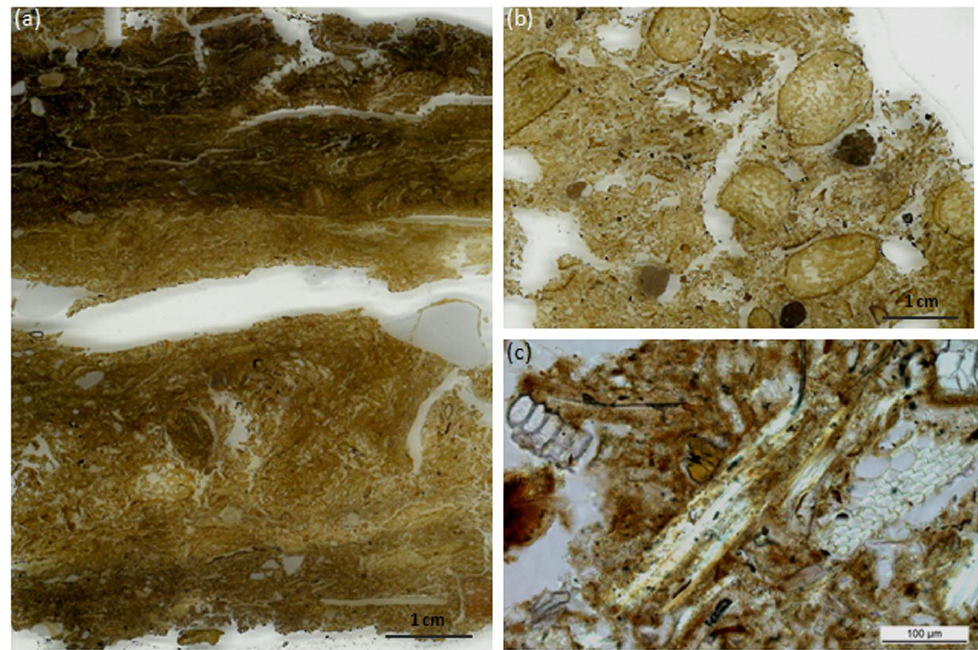
Figure 2. Modern dung cakes from Central Anatolia in Turkey (ethnographic and sample descriptions can be found in [6,29]). ( a ) Scan of a resin-impregnated thin-section illustrating the trampled structure of compacted cattle faeces from an enclosure containing organic material and other mineral inclusions; ( b ) scan of a thin-section from a dung cake manufactured in winter composed of sheep dung pellets, organic matter, and mineral inclusions; ( c ) detail of the same sheep dung cake displaying anatomically connected or multicelled phytoliths from leaf epidermal tissues (200×).